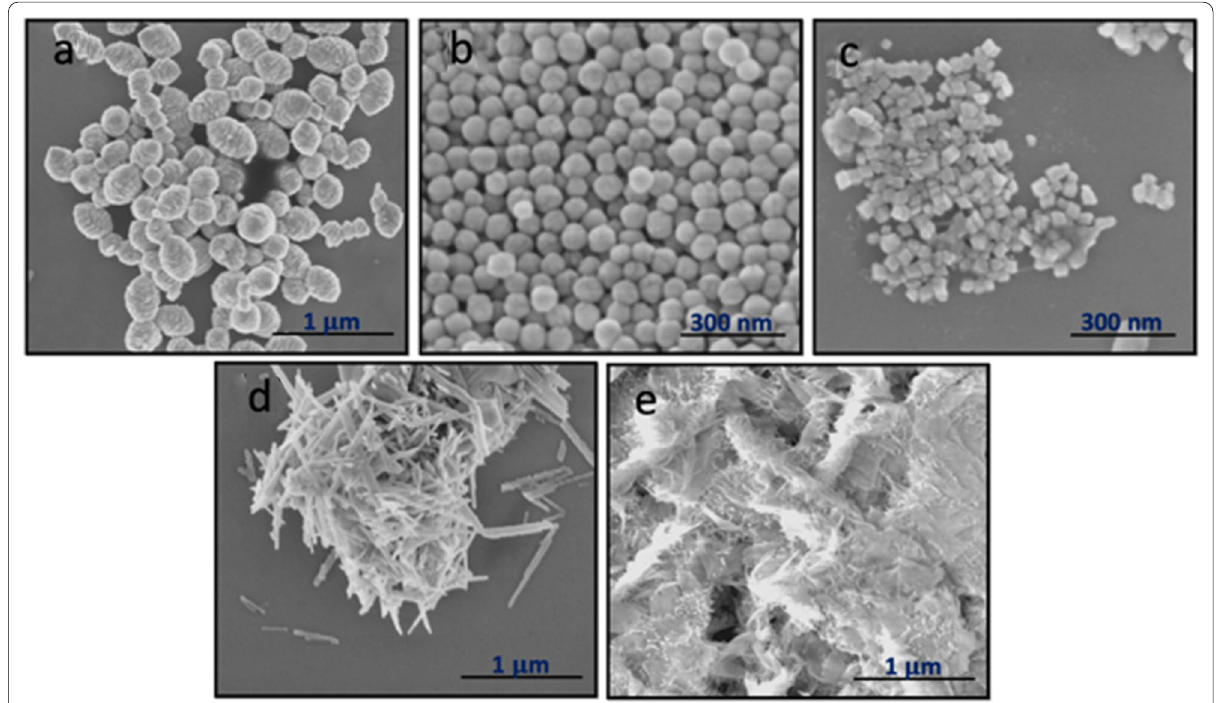
Fig. 2 SEM of the α-Fe 2 O 3 a rugby balls, b nanospheres, c nanodiamonds, d nanorods, and e nanosheets particles